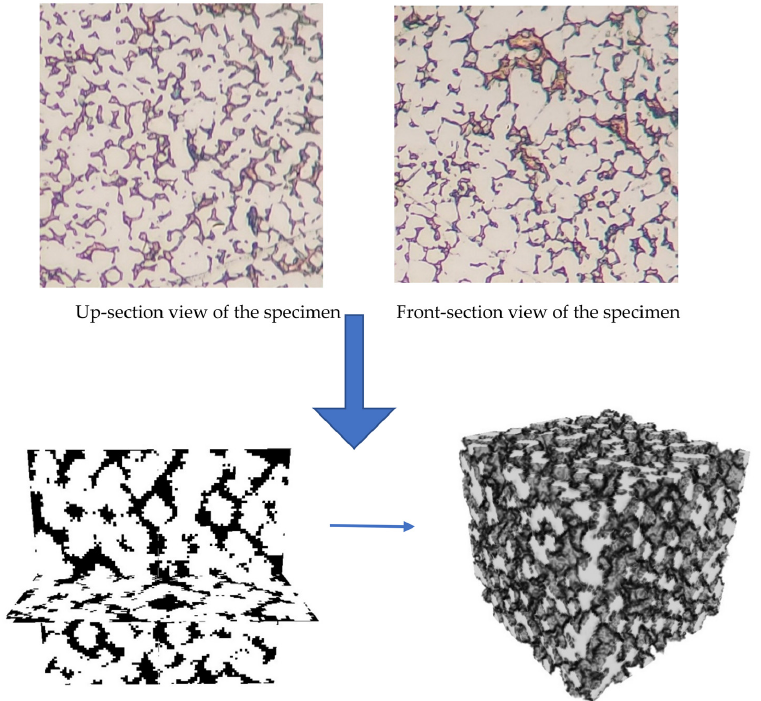
Figure 8. ( Top ) Perpendicular cut-section images of the experimental microstructure; ( Bottom ) the best match in our computational dataset found by the algorithm.